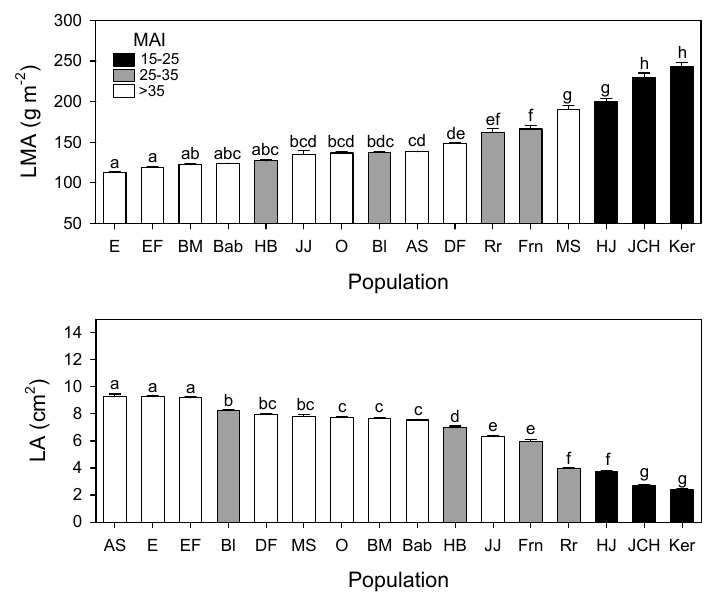
Figure 3. Leaf mass per area (LMA) and leaf area (LA) for the 16 studied Quercus suber populations. Data are mean + SE. Population codes are as in Table 1. Populations are colored according with their De Martonne aridity index (MAI). Different letters indicate significant differences among populations (Tukey’s test, p < 0.05).